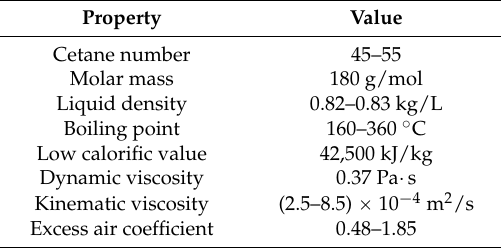
Table 3. Fuel physicochemical properties.